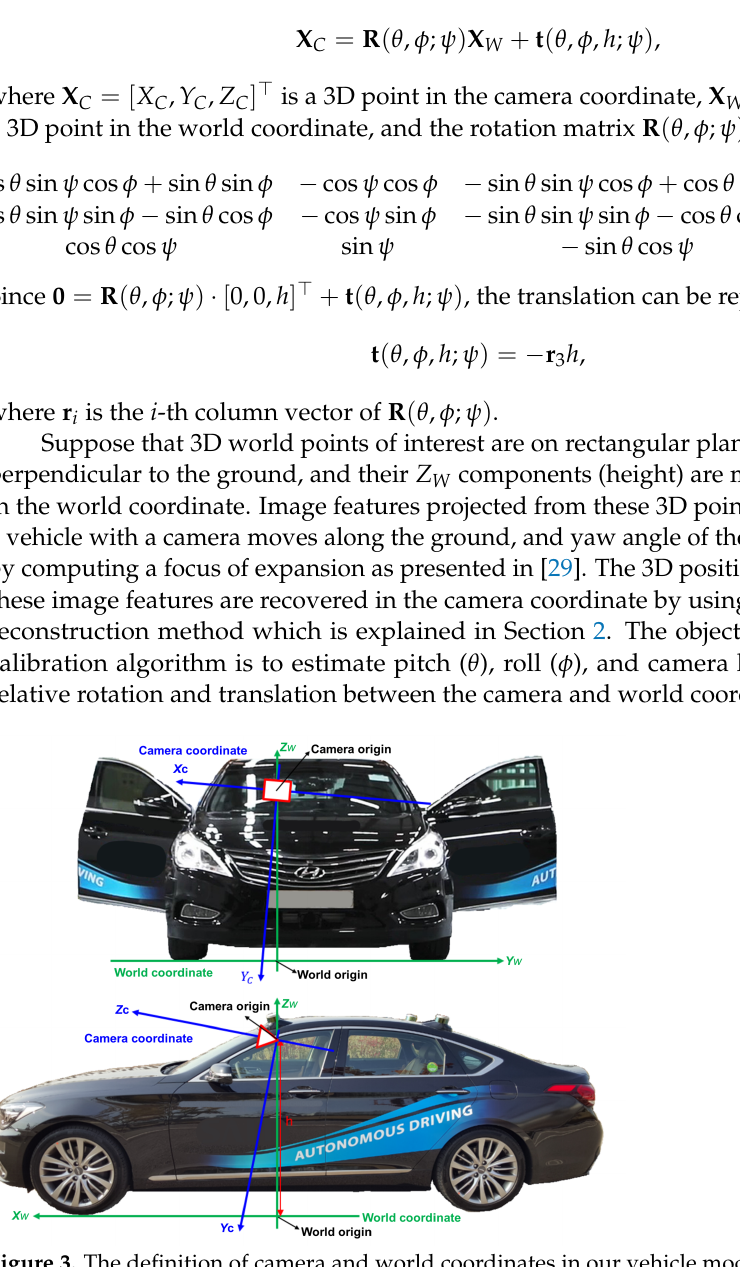
Figure 3. The definition of camera and world coordinates in our vehicle